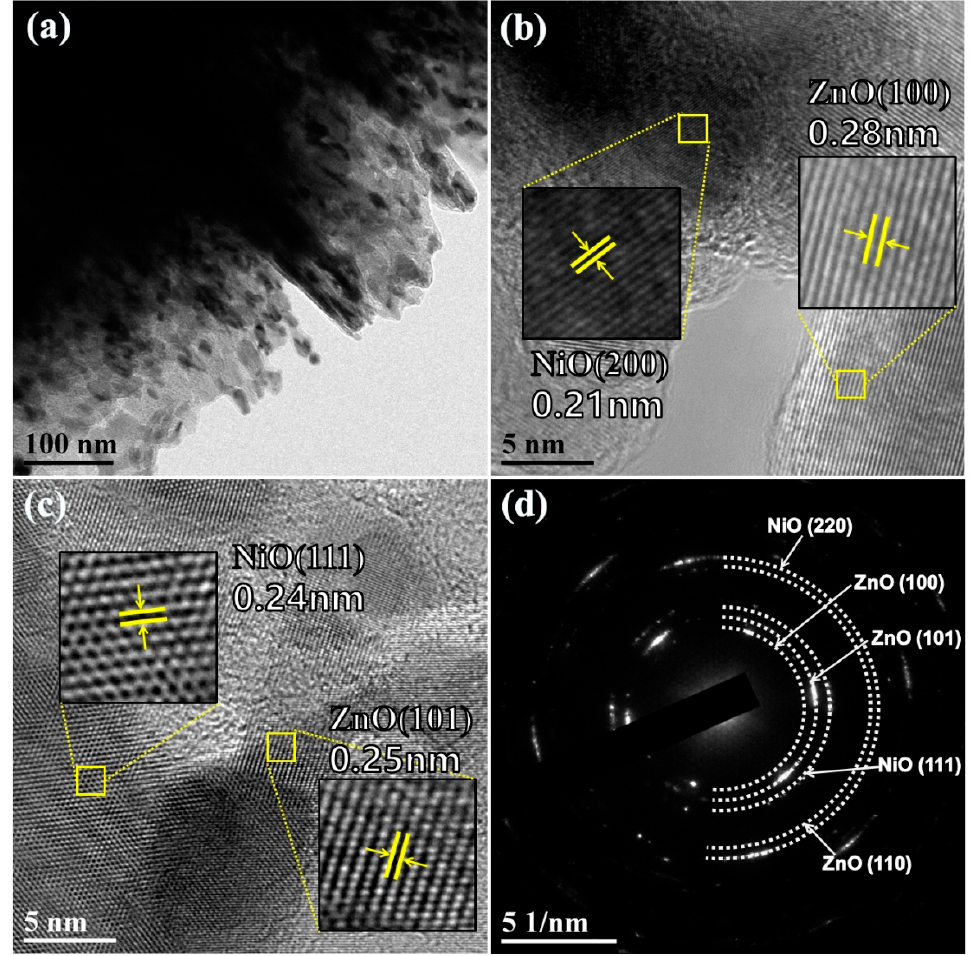
Figure 4. ( a ) Low resolution TEM image of Zn 1 Ni 2 hierarchical structures. ( b , c ) High resolution TEM images of Zn 1 Ni 2 hierarchical structures. ( d ) Selected area electron diffraction (SAED) patterns of Zn 1 Ni 2 hierarchical structures.